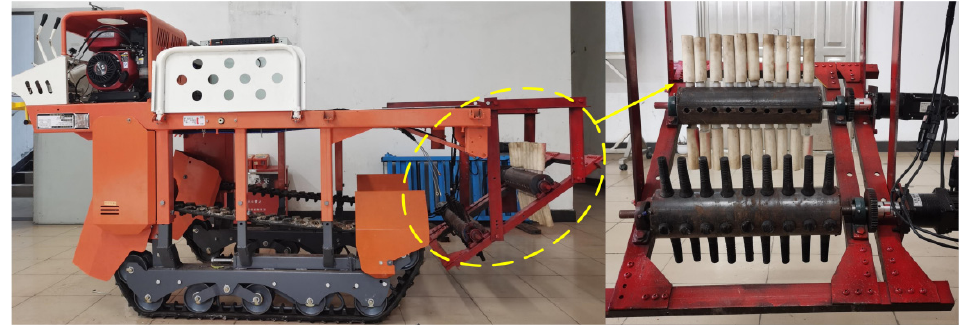
Figure 19. Pineapple harvesting testing machine.